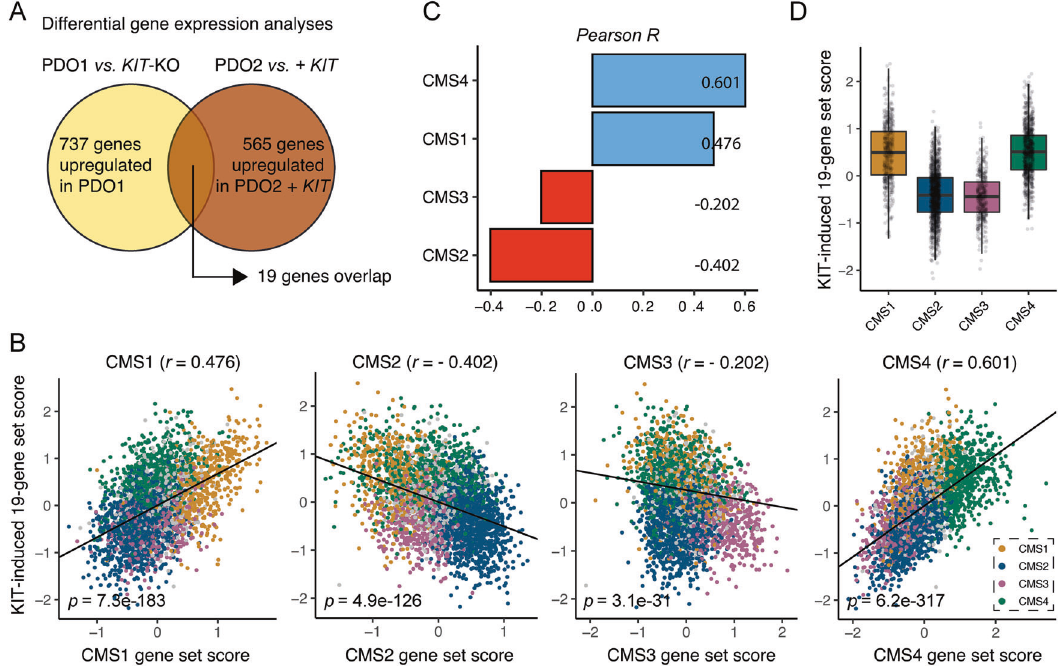
Fig. 4 KIT causes a shift from epithelial (CMS2) to mesenchymal (CMS4) phenotype. A Differential gene expression analysis identi fi ed 19 overlapping genes that were signi fi cantly higher expressed in PDOs expressing KIT compared to those without KIT expression. B Scatter plots showing the correlation of the identi fi ed KIT-dependency gene signature with CMS1-4-identifying genes in the CMS-3232 CRC cohort [1]. Bar plot showing Pearson R values of ( C ). D Score for the KIT-dependency gene signature per CMS-annotated tumor in the CMS-3232